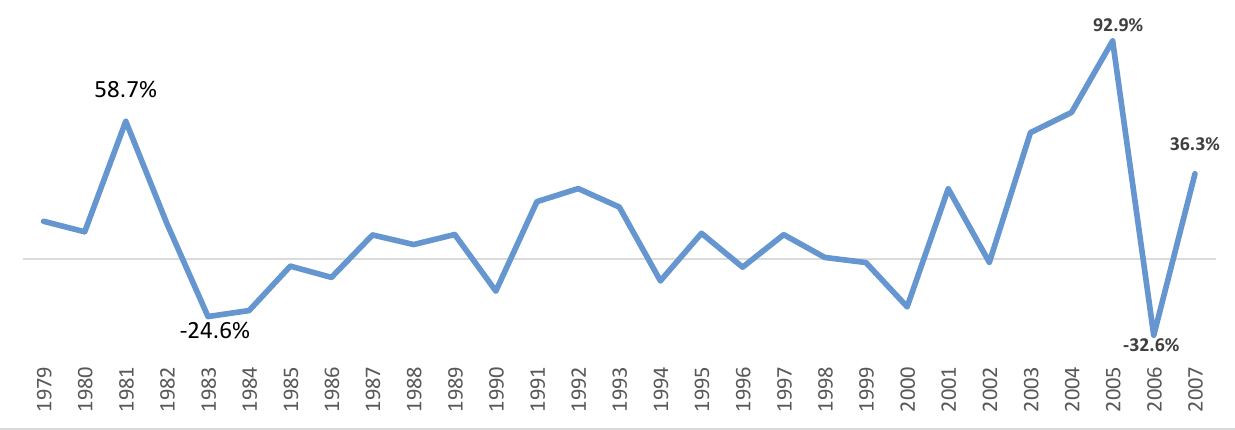
Fig. 1. ASE's Price Index / Weighted by Capitalization (Annual